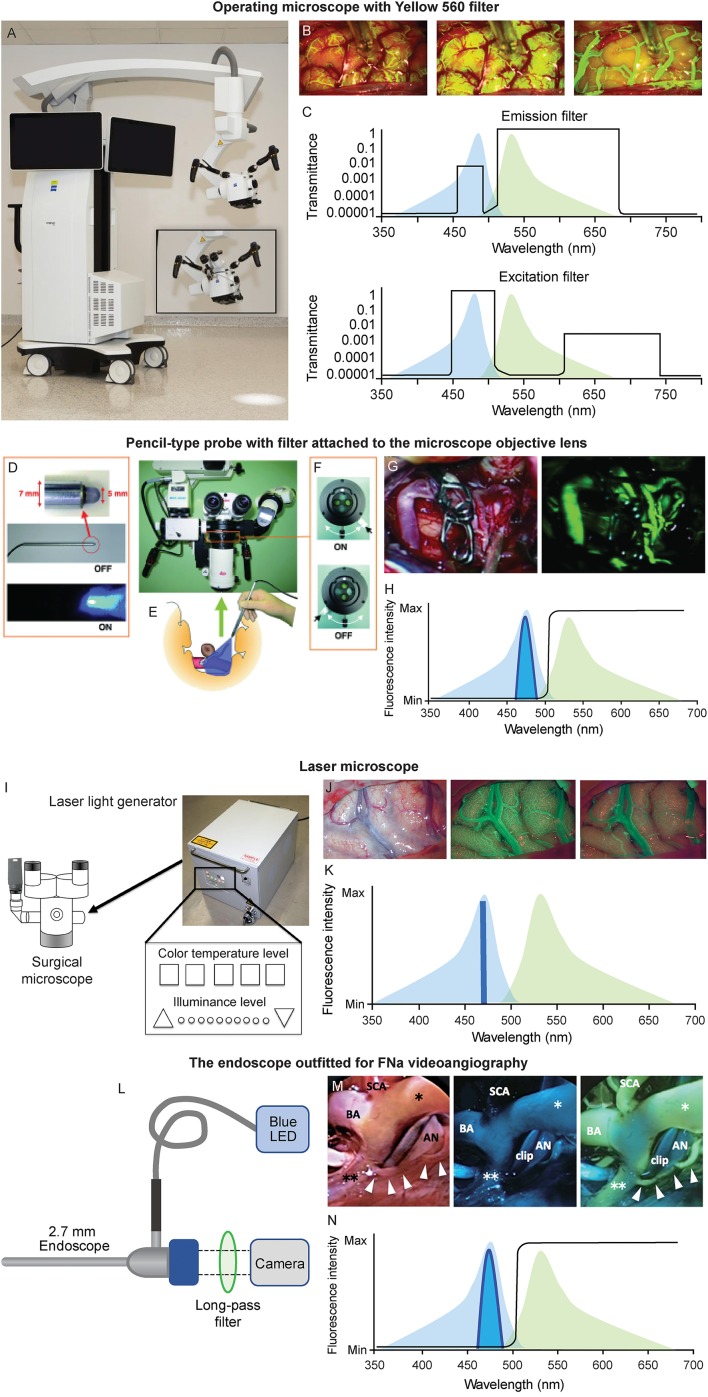
Various platforms used for FNa videoangiography. (A–C) Operating microscope. (A) The operating microscope with Yellow 560 module (ZEISS KINEVO 900, Carl Zeiss AG, Oberkochen, Germany). (B) Intraoperative views of FNa videoangiography (left to right: arterial, capillary, and venous phases). (C) Patented filter combinations used in the operative microscope balances the intensities of narrow bands of excitation and emitted light to create a clear operating field view with yellow fluorescence of fluorescein. The excitation (bottom) and emission (top) profiles of fluorescein (peaks are 485 nm, blue; 514 nm, green, respectively) are shown on the background. The transmittance of filters at various wavelengths results in the uniform intensity of all bands, with a higher intensity of emitted yellow light. (D-H) Pencil-type probe with filter attached to the microscope objective lens. (D) The pencil-type probe with blue LED emission. (E) Sketch demonstrating the intraoperative usage of the probe. (F) The switch of the filter adapted to the operating microscope. (G) The intraoperative view using this device (left, fluorescence off; right, fluorescence on). (H) A diagram showing optical setup of the device. Blue LED light is concentrated around 465 nm, and a long-pass filter (black line) allows green emission light into the camera. (I-K) The laser microscope. (I) The illuminating device. (J) Images of the laser FNa videoangiography (left to right: intraoperative image under white light, capillary phase and venous phases of the FNa videoangiography). (K) Regular excitation (light blue) overlapping the emission (light green) laser light contains light only at 464 nm wavelength and does not interfere with the emission light; thus, the videoangiogram has good contrast. (L–N) An endoscope outfitted for FNa videoangiography. (L) A 2.7-mm straight endoscope is connected to a blue LED light source and a long-pass filter is inserted at the camera attachment. (M) The intraoperative view of endoscopic FNa videoangiography (left to right: under white light, under the blue LED before FNa injection, and after FNa injection). (N) The diagram showing optical setup of the device. Blue LED light is concentrated around 465 nm, and a long-pass filter (black line) allows green emission light into the camera. *, right posterior cerebral artery; **, left posterior cerebral artery; AN, aneurysm; BA, basilar artery; Max, maximum; Min, minimum; SCA, superior cerebellar artery. (A–C,H,K,L,N) are used with permission from Barrow Neurological Institute, Phoenix, Arizona. (D–G) Are used with permission from Suzuki et al. (37). (I) is copyright of Sato et al. (38) and made available under Creative Commons. (J) is used with permission from Ito et al. (22). (M) is used with permission from Hashimoto et al. (20).